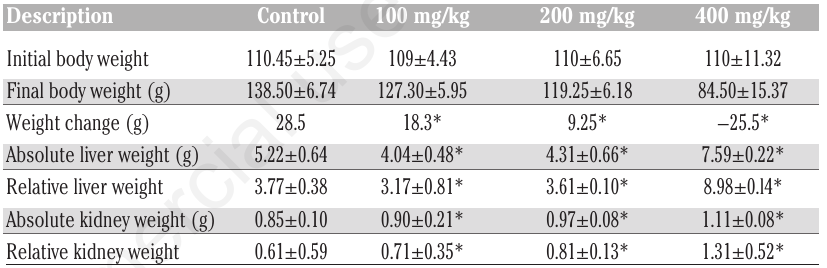
Table 1. Toxicological effects of Solignum ® on body weight, absolute and relative organ weights of rats (g/100g body weight) on the day of sacrifice.